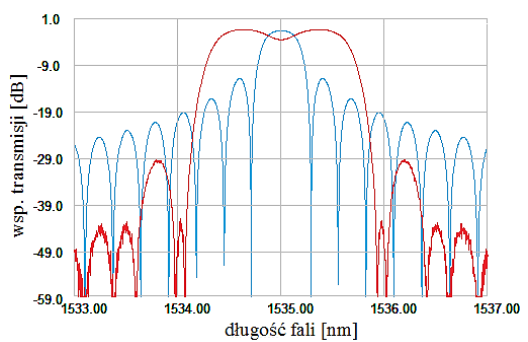
Fig. 15. Comparison of Bragg fiber gratings spectral characteristics without apodization – blue line and apodized Blackman function wsp. a =2- red line.